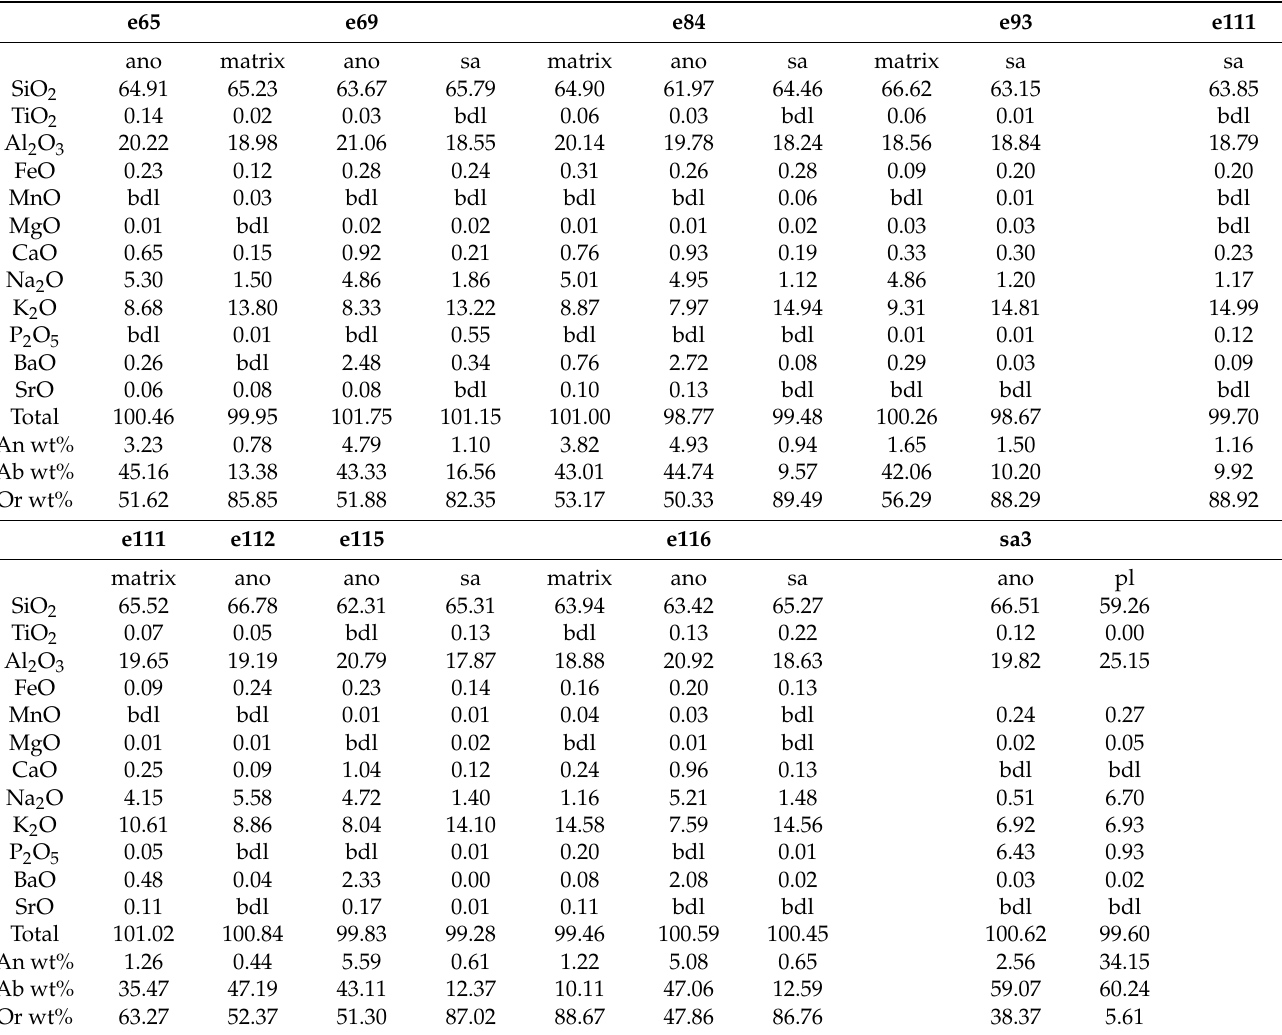
Table 2. Representative feldspar